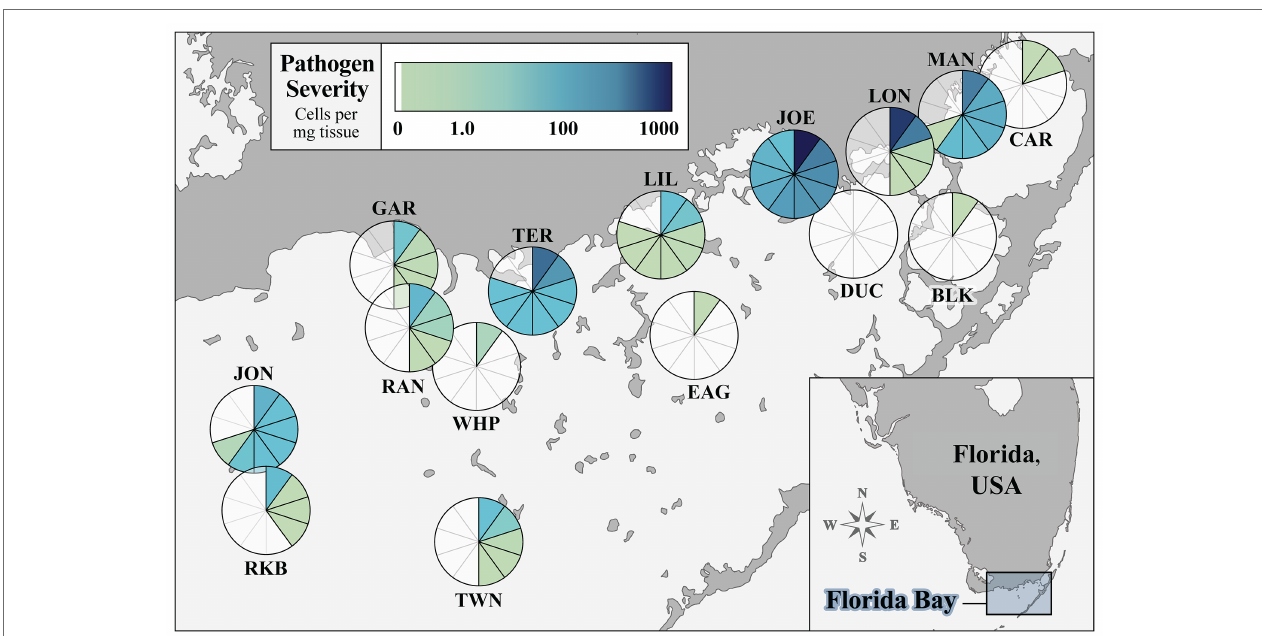
FIGURE 1 | Prevalence and severity of Labyrinthula spp. in turtlegrass among 15 Florida Bay study sites. The pie chart layered over the location of a site represents disease prevalence (percent of samples out of 10 infected with quantifiable pathogen load) at that site. Each pie segment represents one Thalassia testudinum individual and is shaded according to pathogen severity ( Labyrinthula spp. cells per mg dry weight of seagrass tissue). Sample size n = 10 individuals per site. Inset map shows study region relative to the mainland peninsula of Florida, United States.